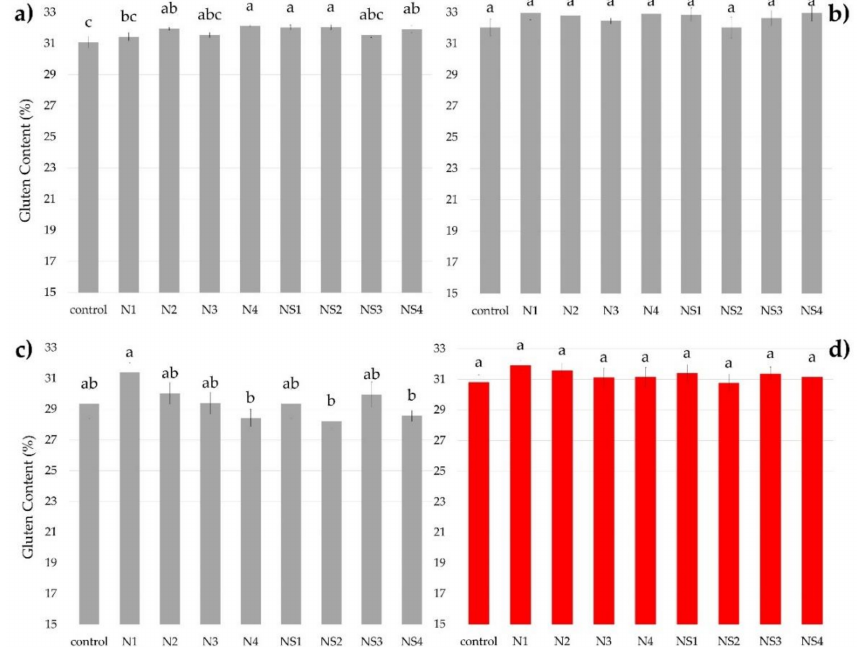
Figure 4. The effect of fertilizer treatments on gluten content (%) in the grain, ( a ) growing season 1 (2017–2018), ( b ) growing season 2 (2018–2019), ( c ) growing season 3 (2020–2021), ( d ) average yield. The same letters above the columns describe no statistically significant differences between treatments (LSD test). Each growing season was evaluated separately. Standard error (SE) is expressed by error